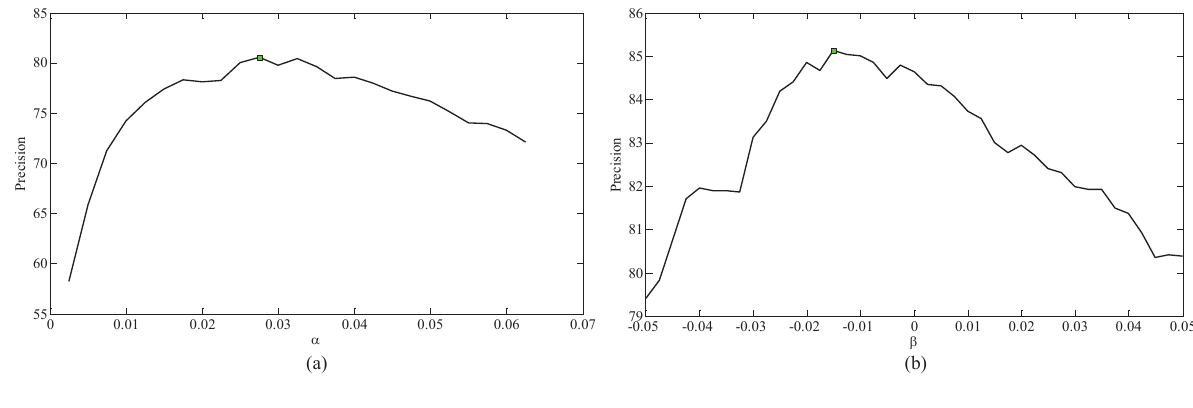
Figure 9. The curve of precision vs . α and β for ATR. Table 4. Accuracy of infrared ATR (%) for RLTP and LTP under different training datasets. Methods